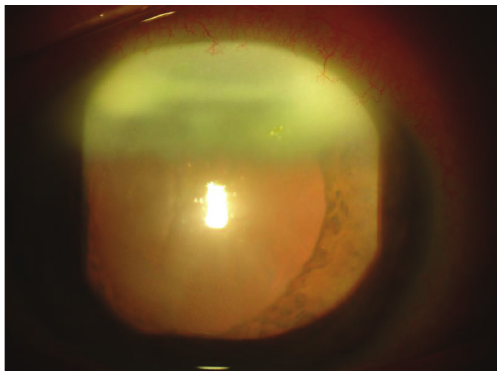
Figure 1: Slit lamp photography showing dense superior intrastromal corneal infiltrate.